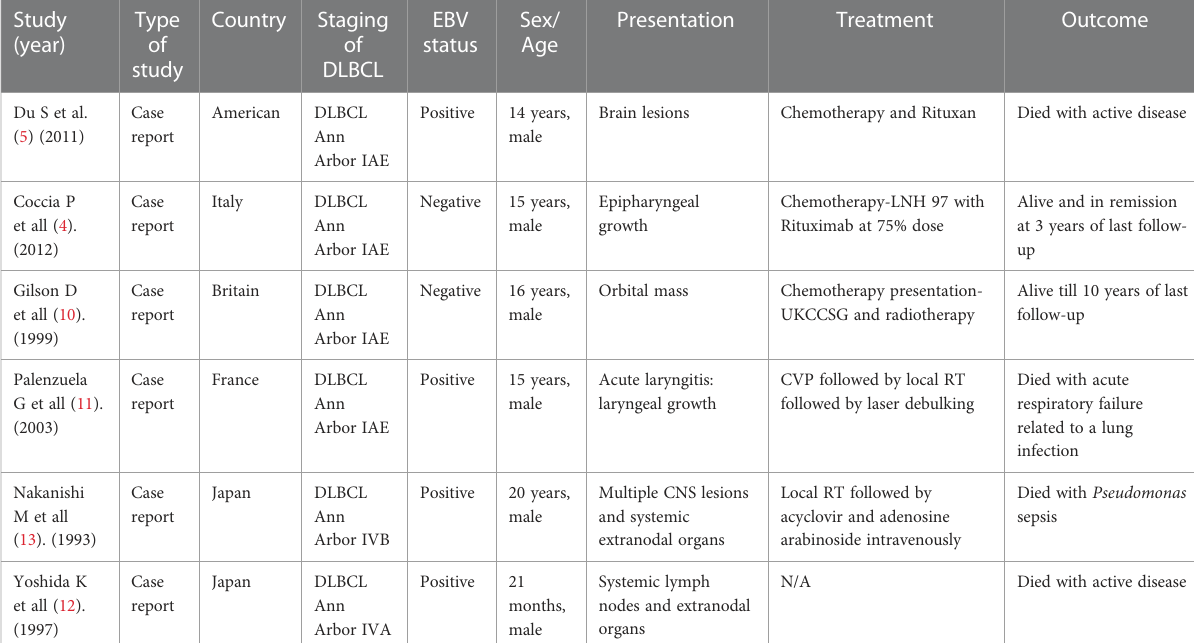
TABLE 2 Extranodal DLBCL in WAS